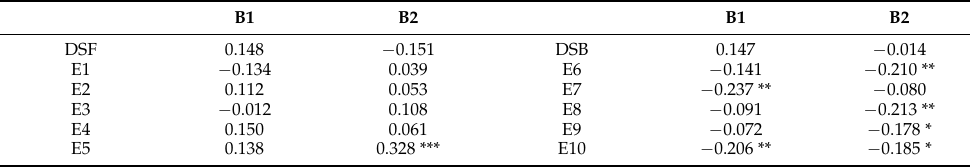
Table 9. Correlation of stay time, MVPA time and restorative effects. B1 B2